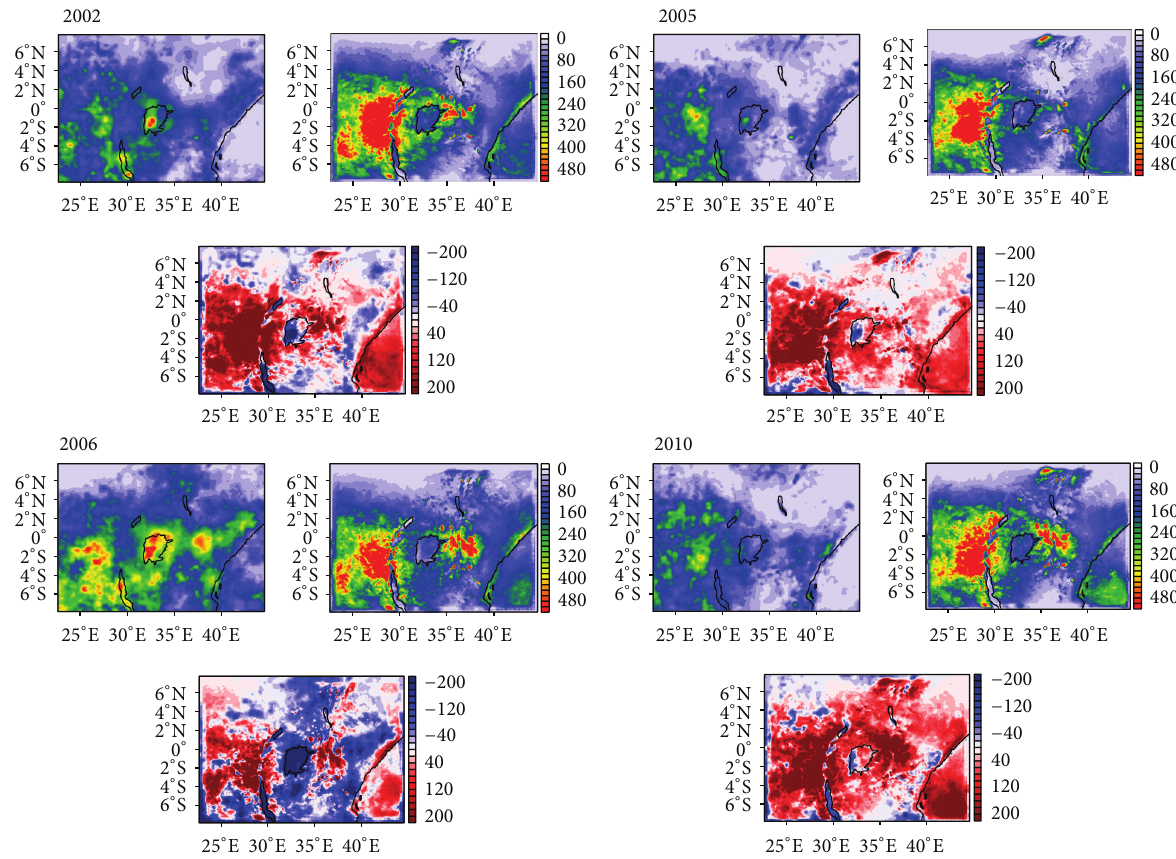
Figure 9: Total rainfall in November in Domain two for each extreme year. WRF rainfall is on the right and TRMM rainfall on the left and the difference between them is the lower